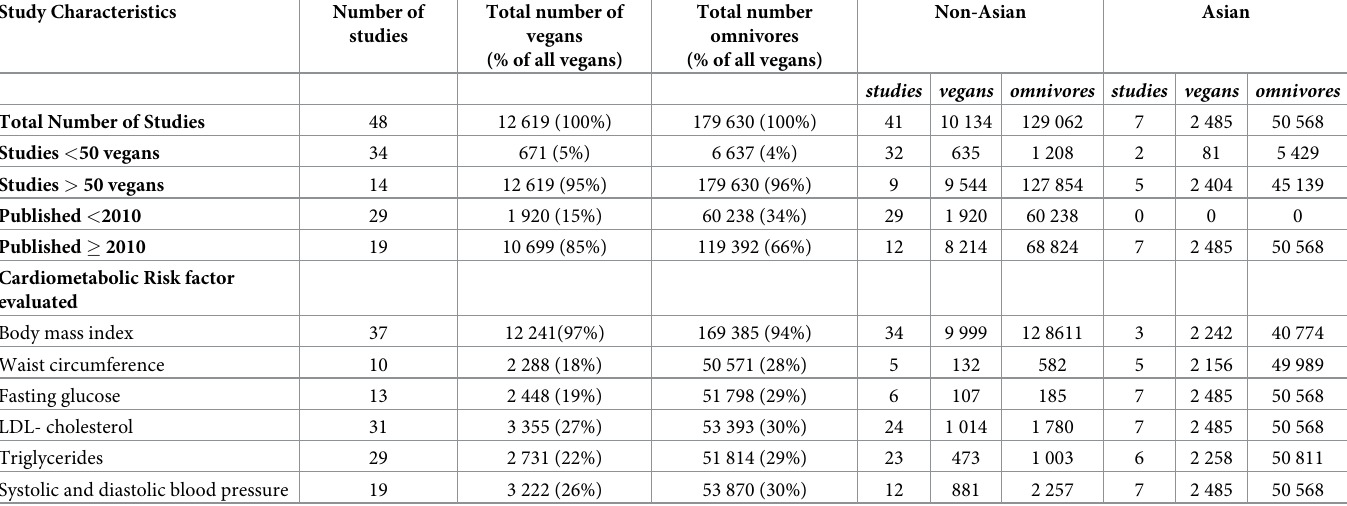
no difference in cardiometabolic risk factors between vegans and omnivores. Table 2. Summary of studies included in the